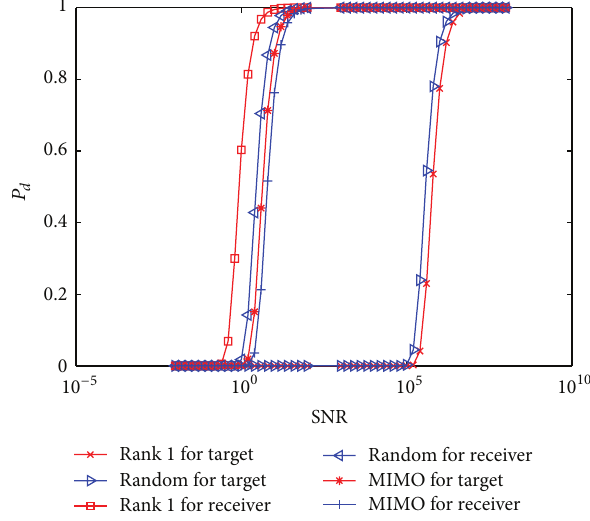
Figure 8: Comparison of detection